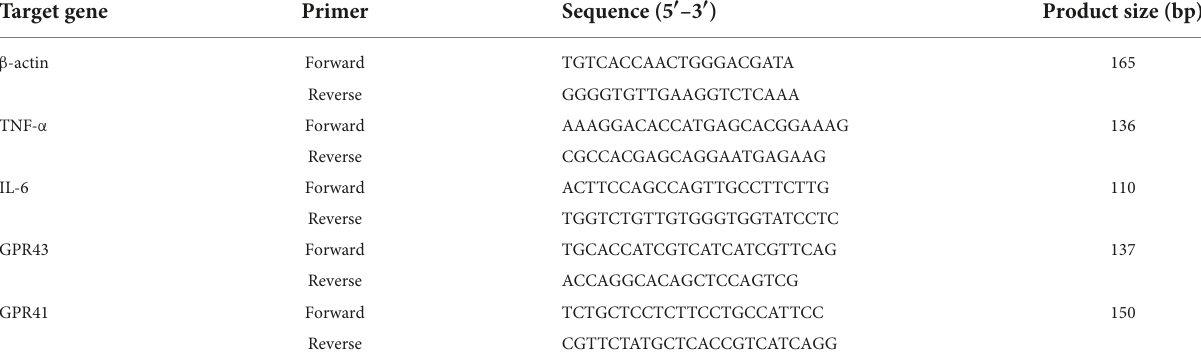
TABLE 1 The primer sequences for amplification in RT-qPCR.